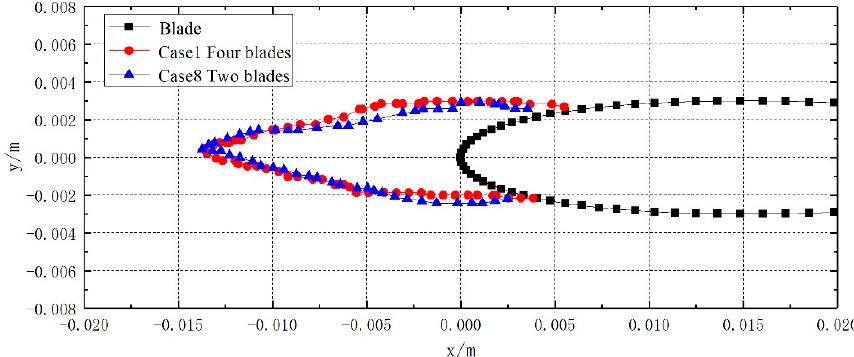
Figure 13. Comparison of ice shapes under different blade numbers.